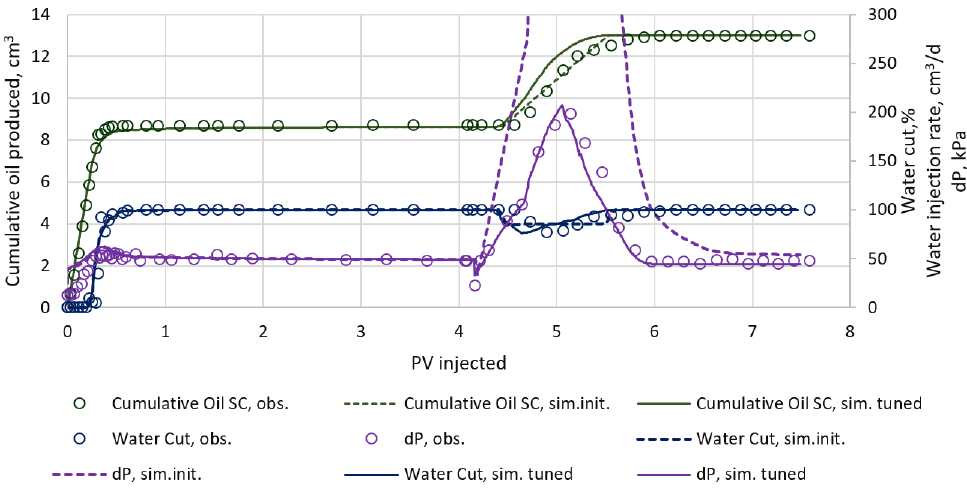
Figure 15. Result of model tuning to experimental data (displacement parameters).